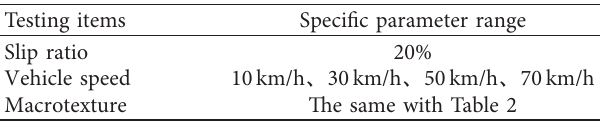
Table 2: Testing conditions of tire-pavement static contact. Testing items